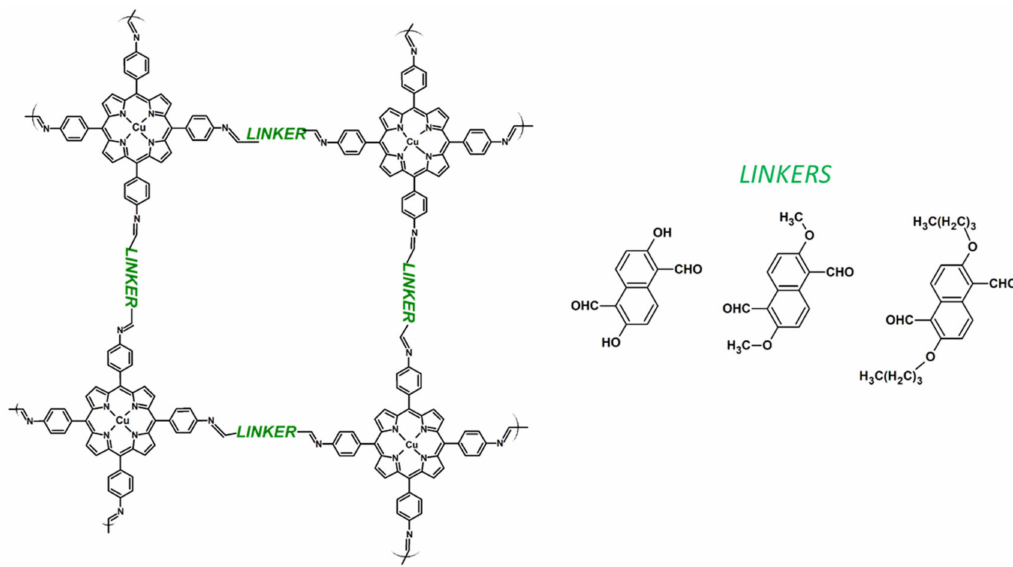
Figure 13. Schematic representation of copper porphyrin-based CMPs with various linkers (investigated in